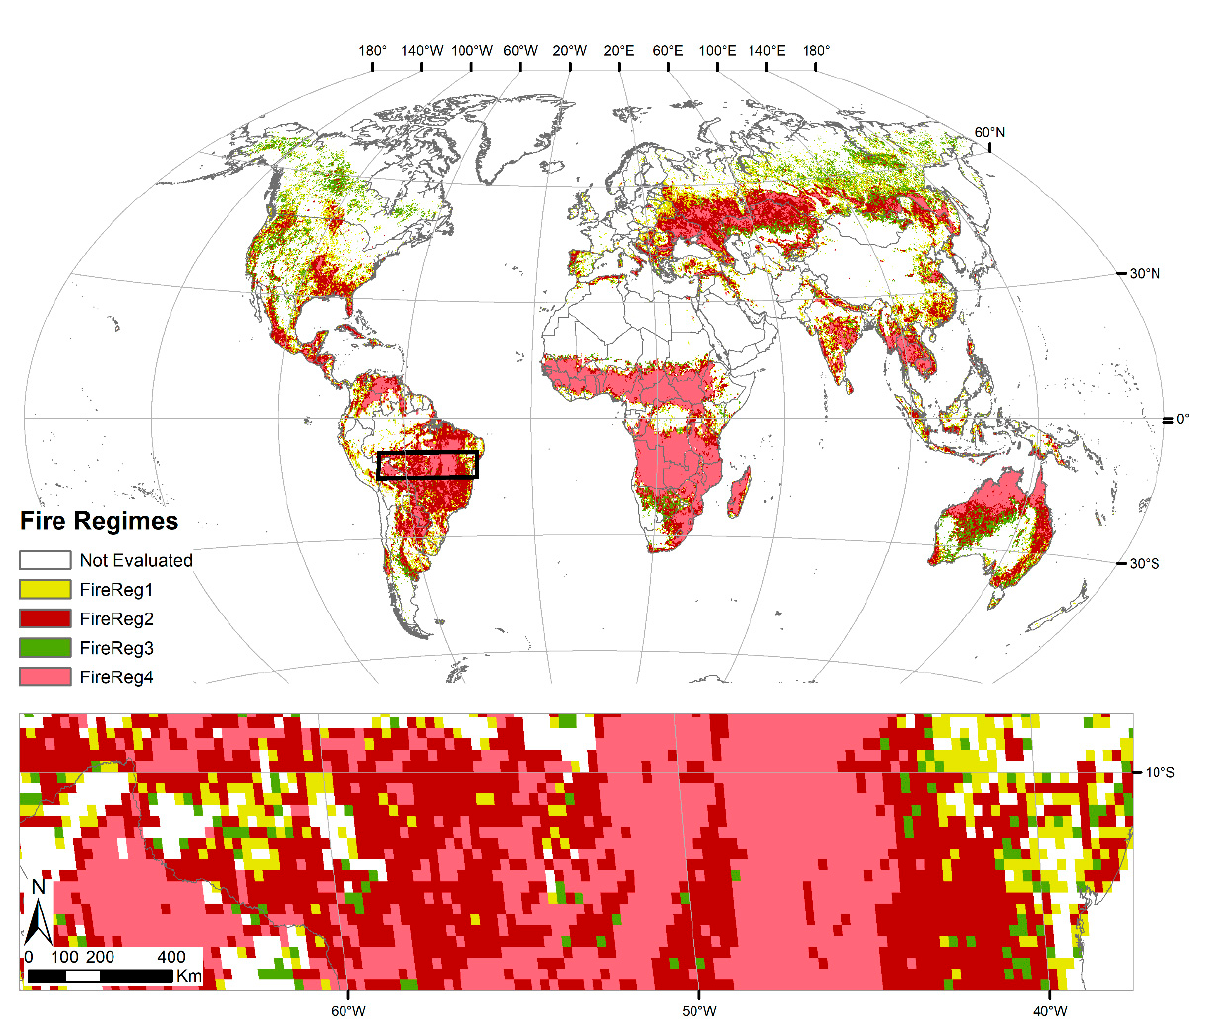
represented 27.76% of the cells assigned to this fire regime, followed by FT7 with 20.43% and FT5 with 13.27%.